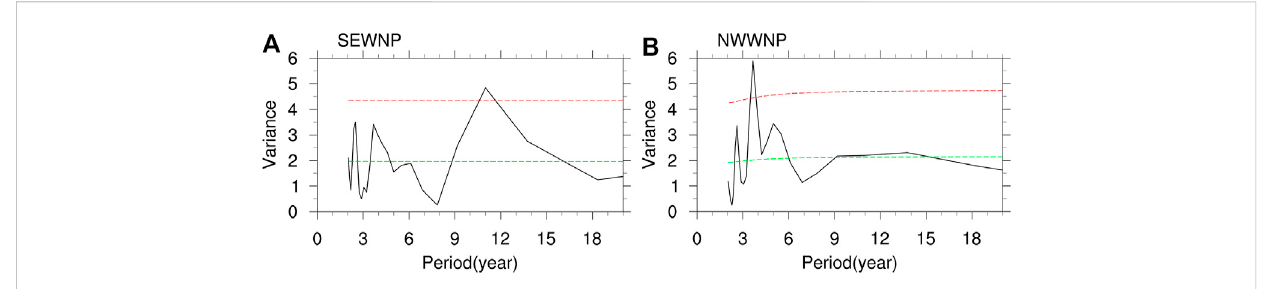
FIGURE 3 PowerspectrumanalysisofTCgenesisfrequencyinthe (A) SEWNPand (B) NWWNP.Thegreenlineindicatestherednoisespectrumandtheredline denotes statistical signi fi cance at the 95% con fi dence